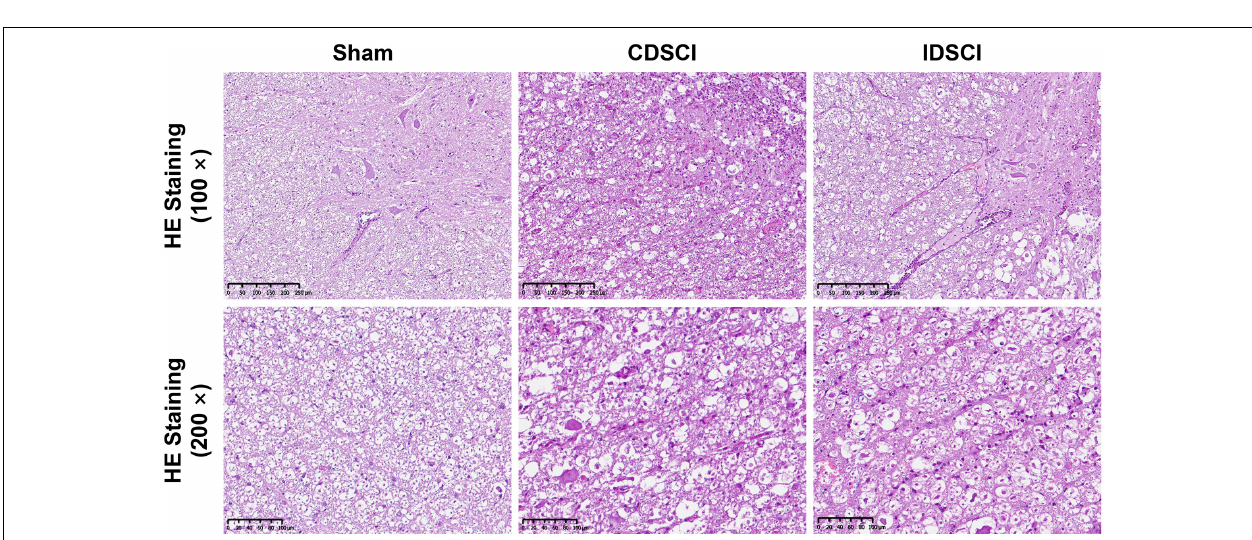
FIGURE 3 | The pathological changes in the spinal cord tissues of different groups after DSCI. The representative images of spinal cord tissues stained with HE staining (scale bar = 200 µ m or 100 µ m) were shown.